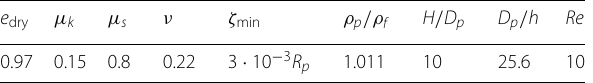
Table 2 Simulation parameters of the pressure-driven flow √ τ /ρ scenario, where u τ = w f is the friction velocity at the fluid/particle interface, U b is the bulk (average) velocity of the fluid, τ w is the shear stress at the fluid/particle interface, ν f the kinematic viscosity, L x , L y , and L z are the spatial extents of the computational domain in the Cartesian space, and h is the grid cell size Re = U b L y /ν f 9.9 D + = u τ D p /ν f